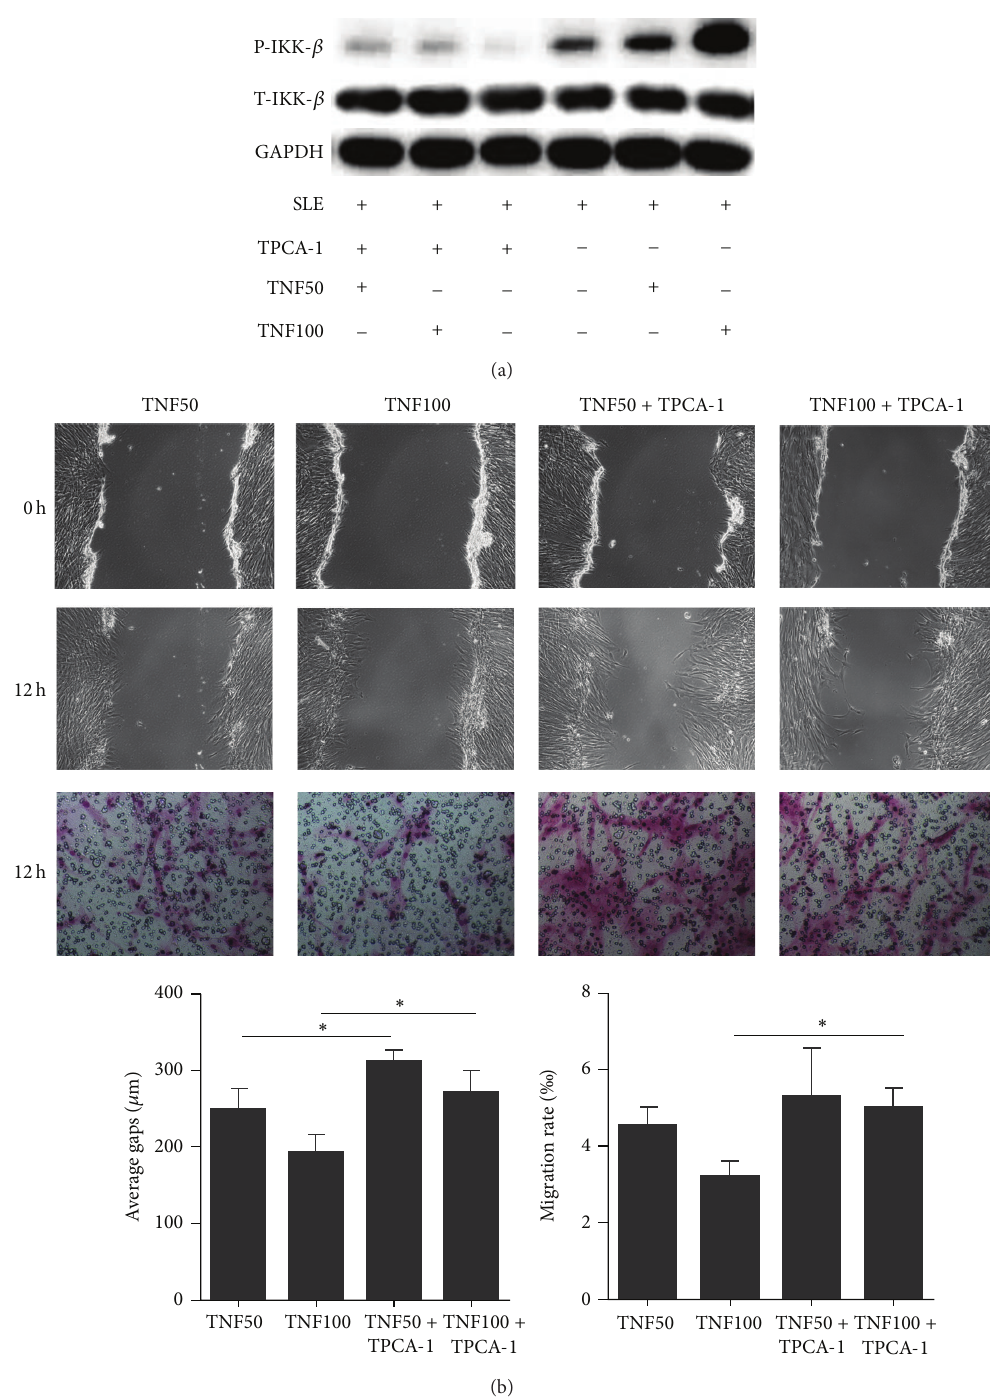
Figure 5: Upregulation of p-IKK- 𝛽 involved in TNF- 𝛼 induced abnormal migration of SLE BMSCs. (a) Protein levels of p-IKK- 𝛽 and t-IKK- 𝛽 in SLE BMSCs after TPCA-1 or TNF- 𝛼 treatment. (b) TPCA-1 could reverse the effect of TNF- 𝛼 on migration capacity of SLE BMSCs in the wound healing and transwell migration assays ( 𝑛 = 6 ). TNF50: TNF- 𝛼 : 50 𝜇 g/L; TNF100: TNF- 𝛼 : 100 𝜇 g/L. ∗ 𝑃 < 0.05